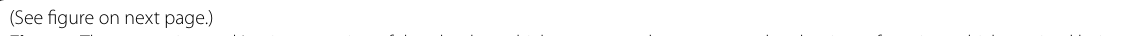
figure on next Fig. 5 a The proportion and Logit proportion of the plantlets which were rooted or non-rooted at the time of potting, which survived being transferred to the nursery growing conditions. b The proportions of the ash plantlets which survived the transfer to the nursery from the in vitro rooting procedure, per trial. The left-hand graphs show the absolute proportions while the right-Shand graph shows the logit transformed proportions. Note that the differences in the survival rates between the rooted and non-rooted plants was much smaller than the batch